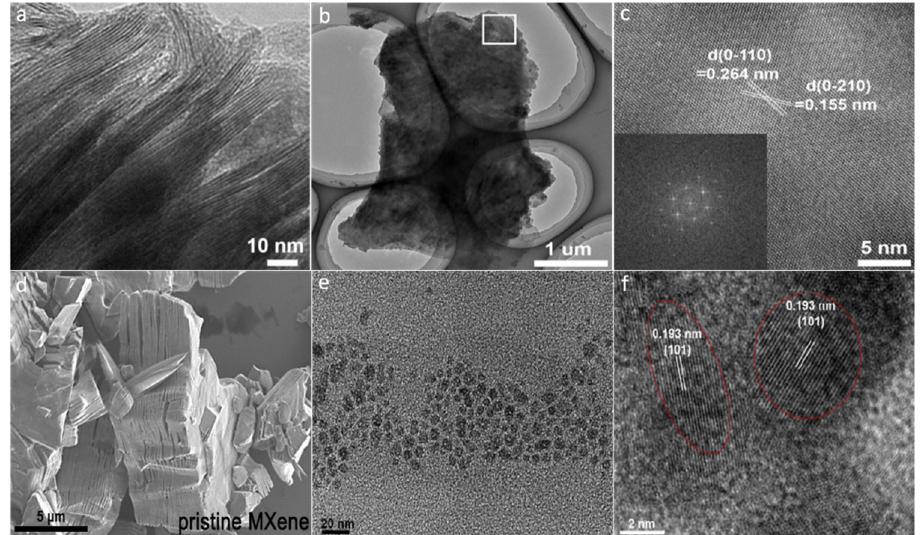
Figure 5. TEM images: ( a ) Side view, ( b ) bird’s-eye view, and ( c ) selected area HR-TEM with inset FFT image of h- Ti 3 C 2 flakes. Reproduced with permission from ref. [62] Copyright 2018, Elsevier. ( d ) SEM micrograph of pristine MXene, ( e ) TEM micrograph, and ( f ) HR-TEM micrograph of N-MXene QDs. Reproduced with permission from ref. [64] Copyright 2020, Elsevier.